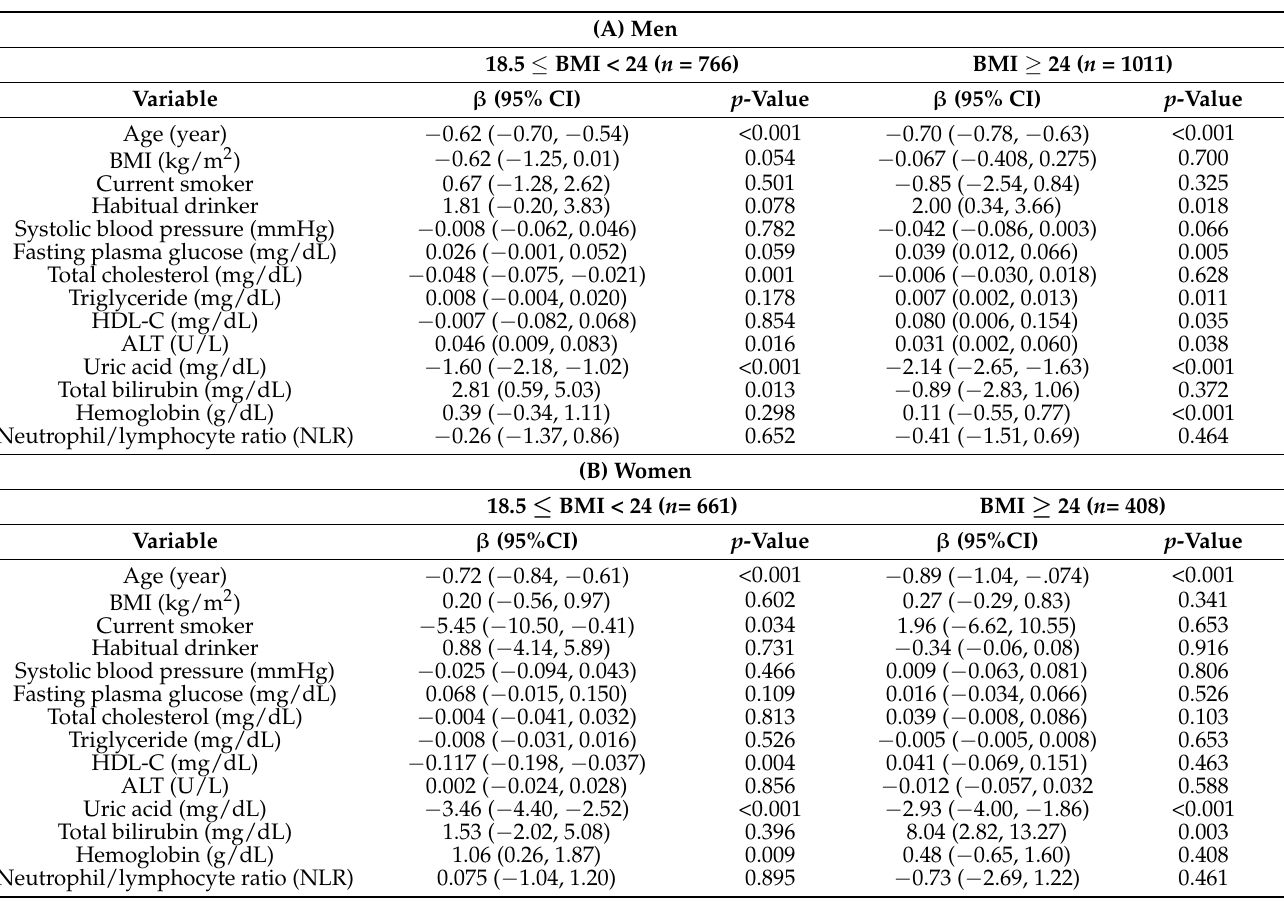
Table 5. Regression Analysis of eGFR (mL/min/1.73 m 2 ) against Neutrophil/Lymphocyte Ratio (NLR) Stratified by BMI Status in Men ( A ) and Women ( B